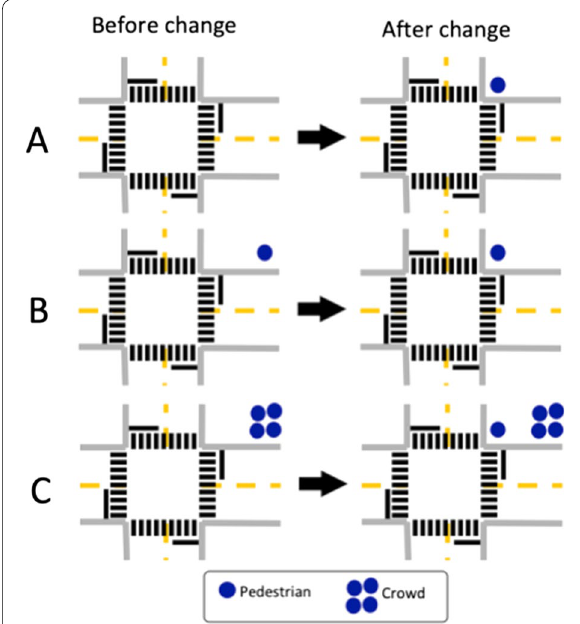
Fig. 2 Illustrations of the different conditions. A There is no pedestrian at the intersection, and then, a critical pedestrian appears near the crosswalk. B There is a pedestrian far from the crosswalk that disappears simultaneously as the critical pedestrian appears near the crosswalk. C There is a crowd far from the crosswalk, and the critical pedestrian appears near the crosswalk. In all three conditions, the critical pedestrian appeared in the same location. These conditions were also used for the distance-triggered pedestrian or a crowd (3 to 8). They varied in clothes and sex/gender and were approximately 1.8 m tall. Pedes- trians for the critical events (section "critical events") appeared at intersections where participants drove straight through. They appeared in two possible loca- tions: near the crosswalk (1.5 m from edge, Figs. 1 and 2) or far from the crosswalk (6.5 m from edge, Fig. 2).